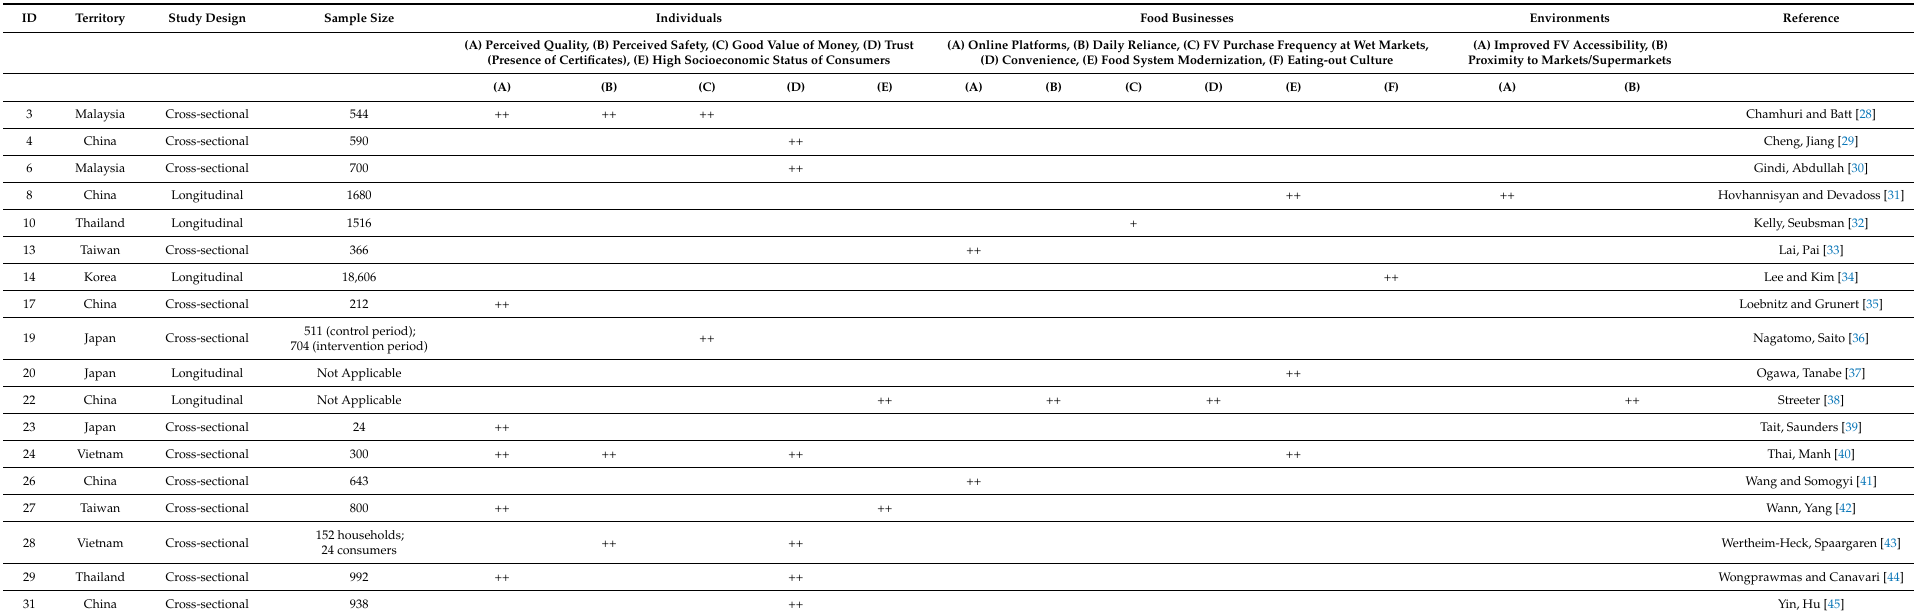
Table 3. Facilitators of FV consumption in East and Southeast